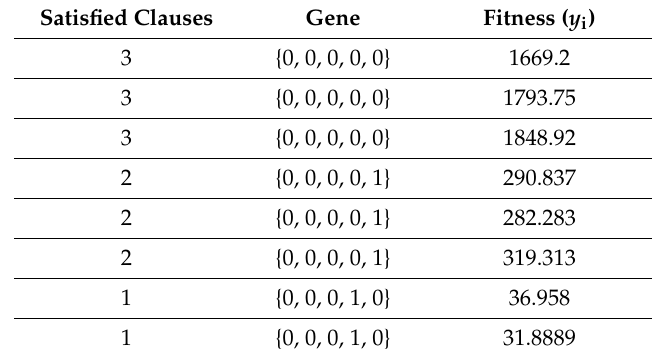
Table 3. In silico screening output for the 2-SAT optimization